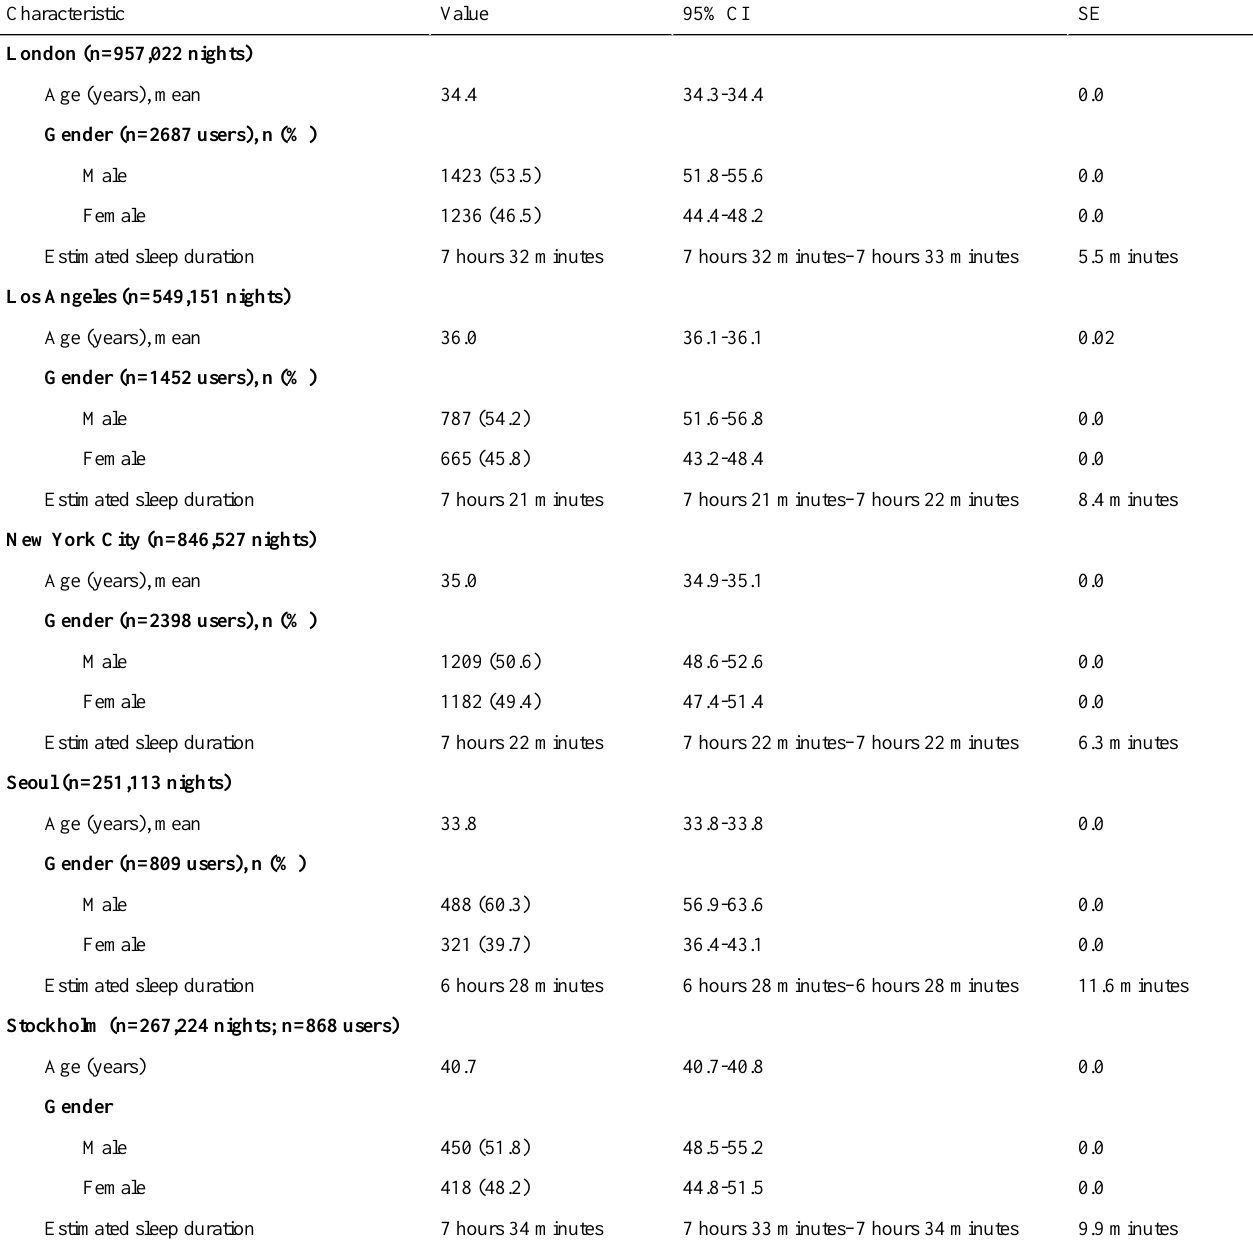
Table 1. Descriptive statistics summarizing the participants’ demographic characteristics and sleep data by city prior to the COVID-19 pandemic (N=2,871,037 nights; N=8,218